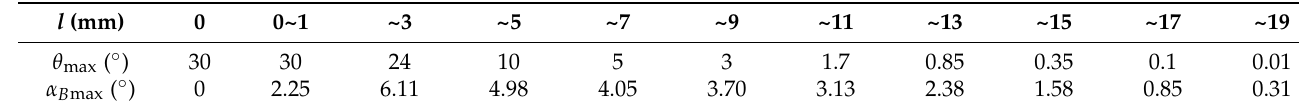
Table 1. Values of l and corresponding θ max and α B max .